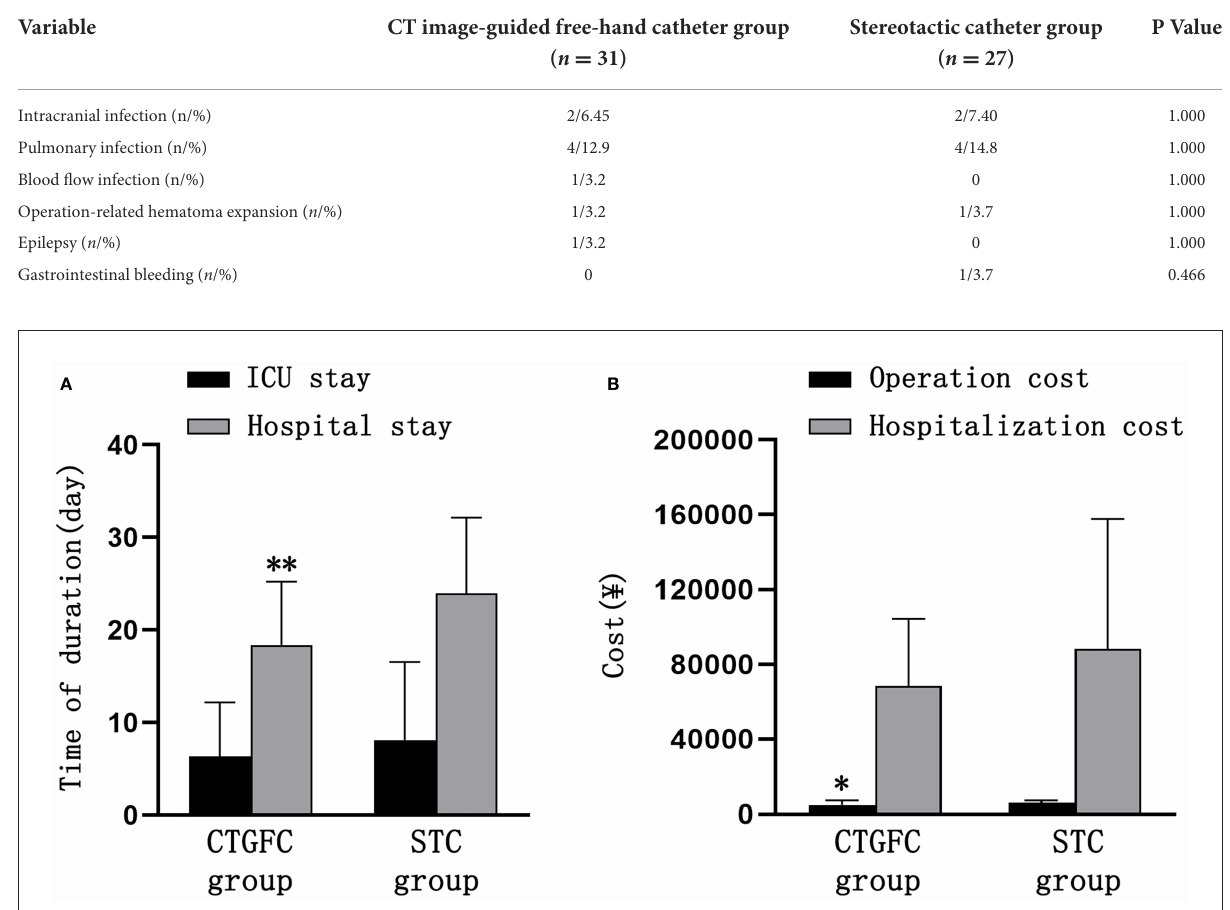
FIGURE4 Comparison of hospitalization-related indicators between the two groups. (A) Length of ICU stay and hospital stay. (B) Operation and hospitalization costs. * p < 0.05 and ** p < 0.01 vs. the stereotaxic surgery group. CTGFC, CT image-guided free-hand catheter technique; STC, stereotactic catheter